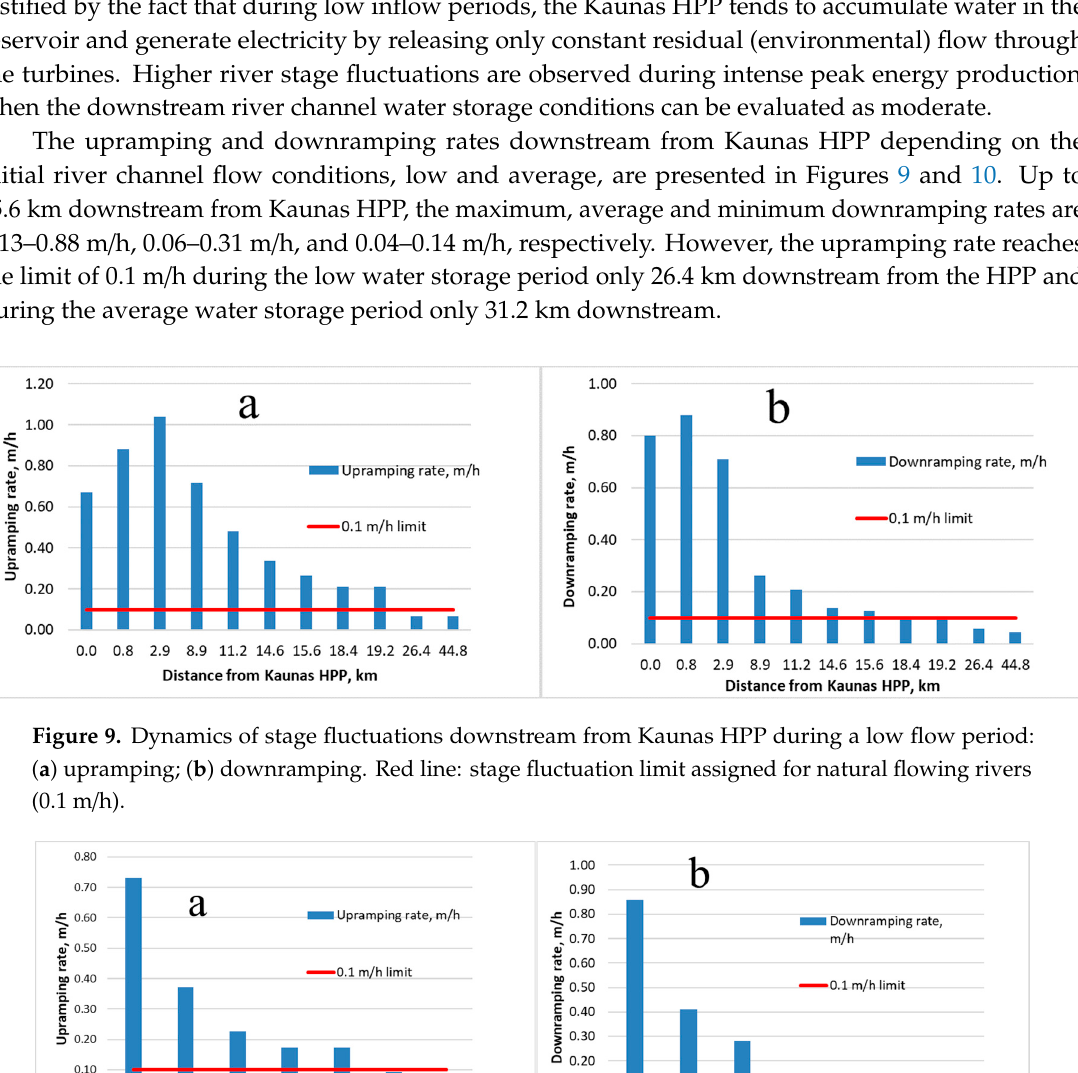
Table 1. Key statistics of gauged stage data series along Nemunas River during low and average channel flow.